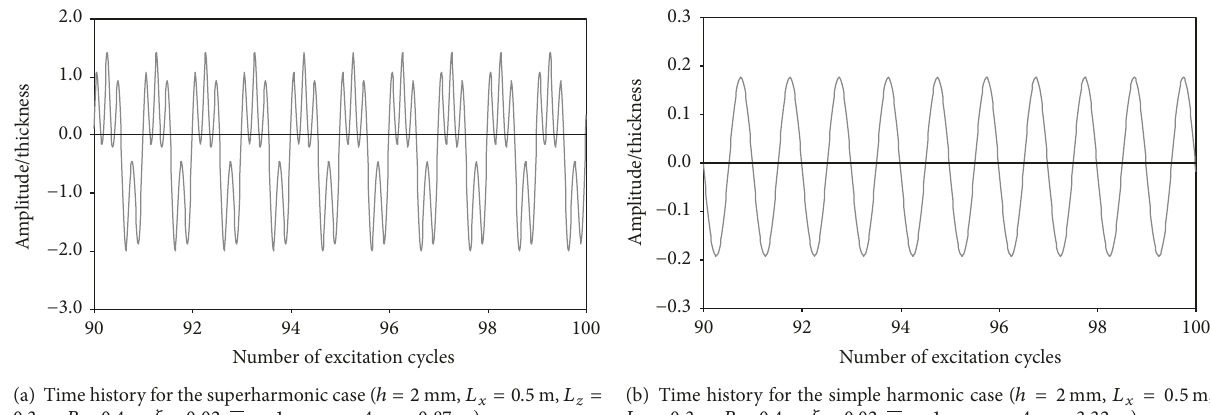
(b) Time history for the simple harmonic case ( ℎ = 2 mm, 𝐿 𝑥 = 0.5 m, 𝐿